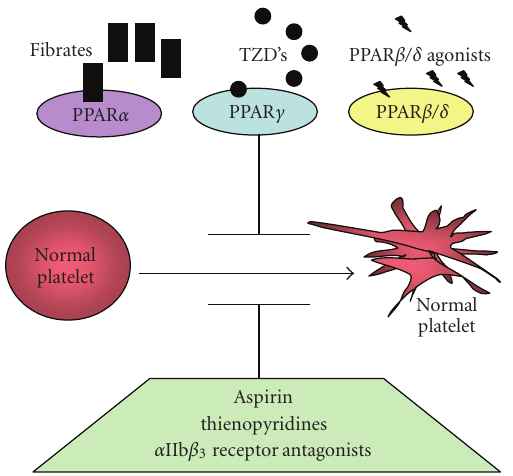
Figure 2: Possible role of PPAR agonists in dampening inflamma- tion and reducing cardiovascular events. PPAR agonists may reduce the risk for thrombosis. Besides playing a role in adipogenesis, lipid metabolism, and insulin sensitivity, PPARs may dampen inflamma- tion by attenuating platelet